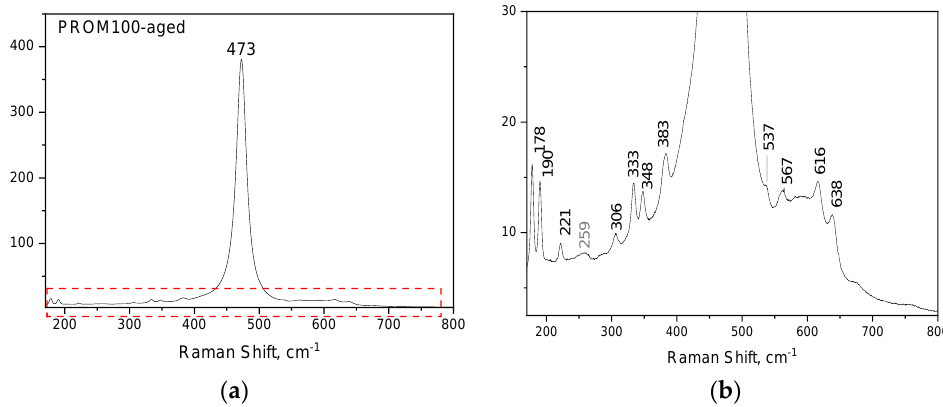
Figure 3. ( a ) Raman spectrum of PROM100-aged; ( b ) focus on the low-intensity bands observed.